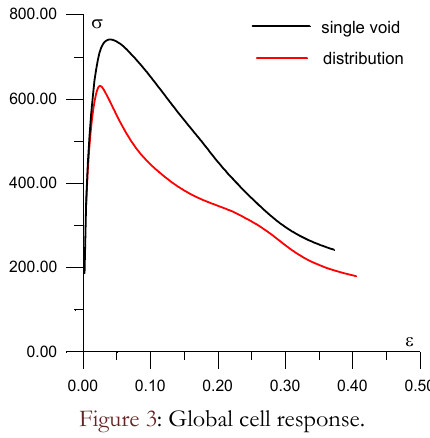
Figure 3: Global cell